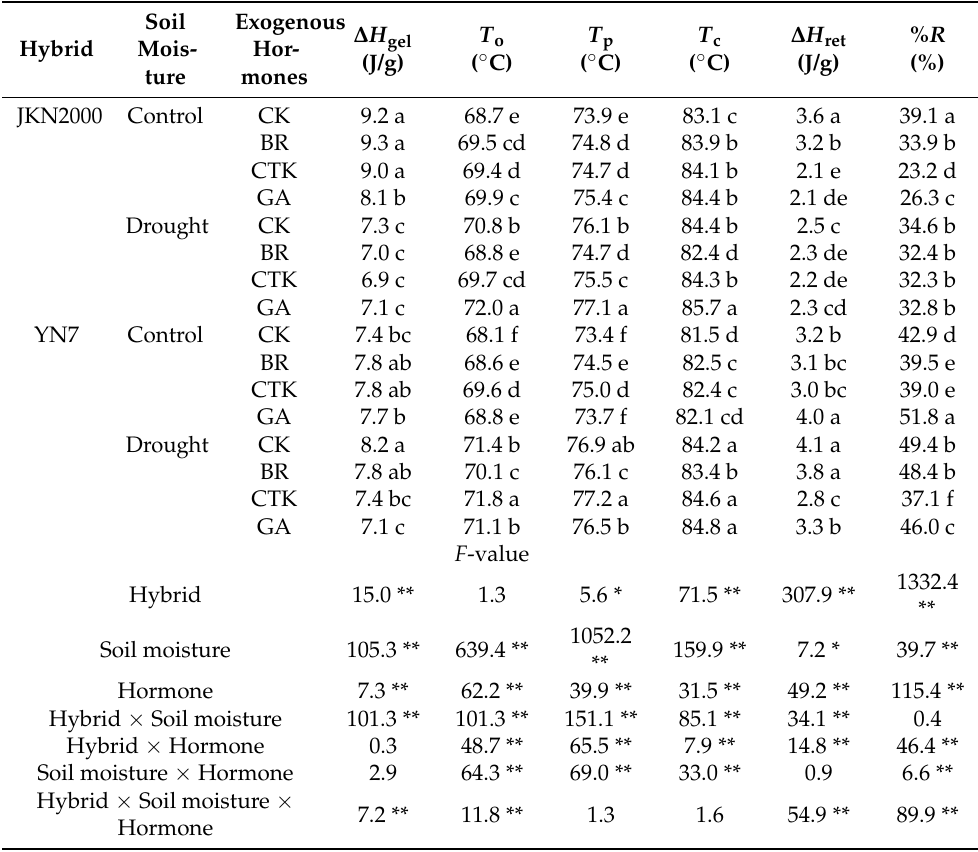
Table 2. The flour thermal properties with spraying exogenous phytohormones under post-silking control and drought